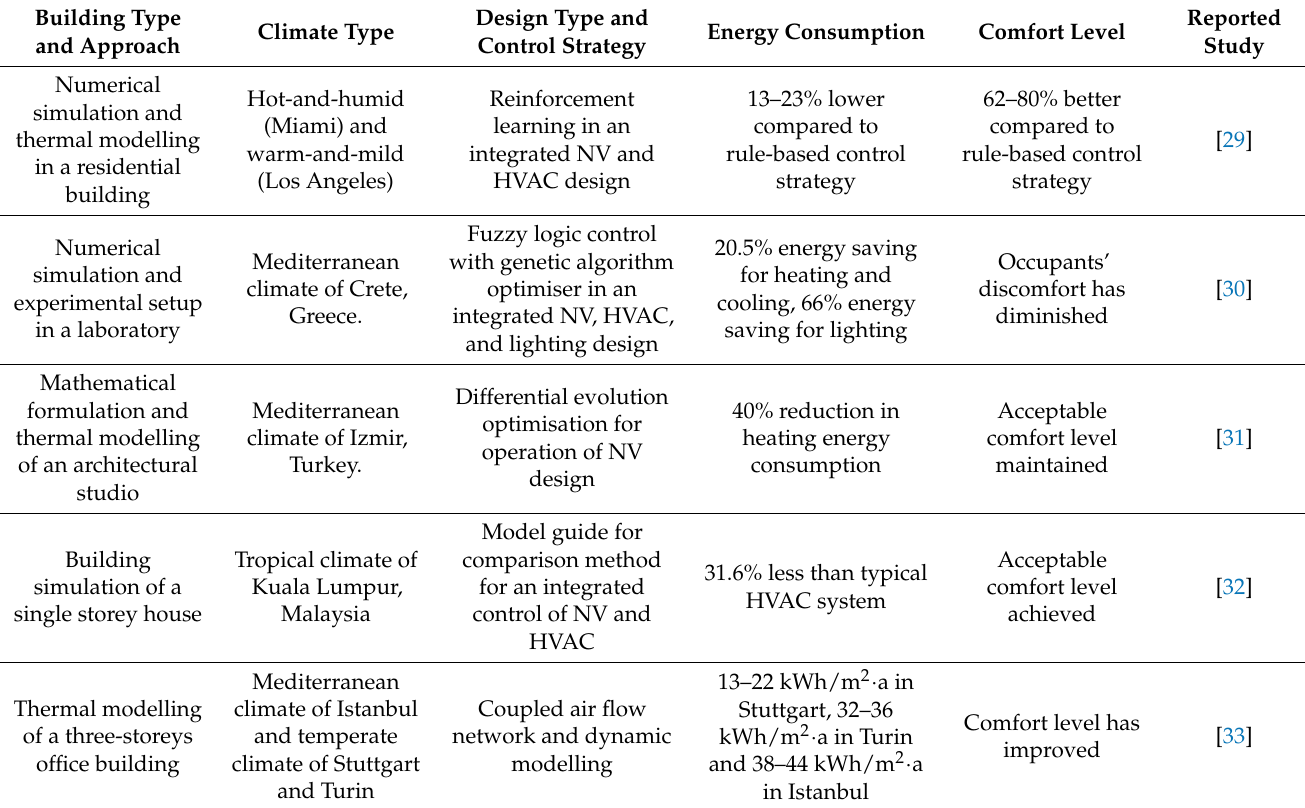
Table 1. Reported studies in the literature on application of natural ventilation design in